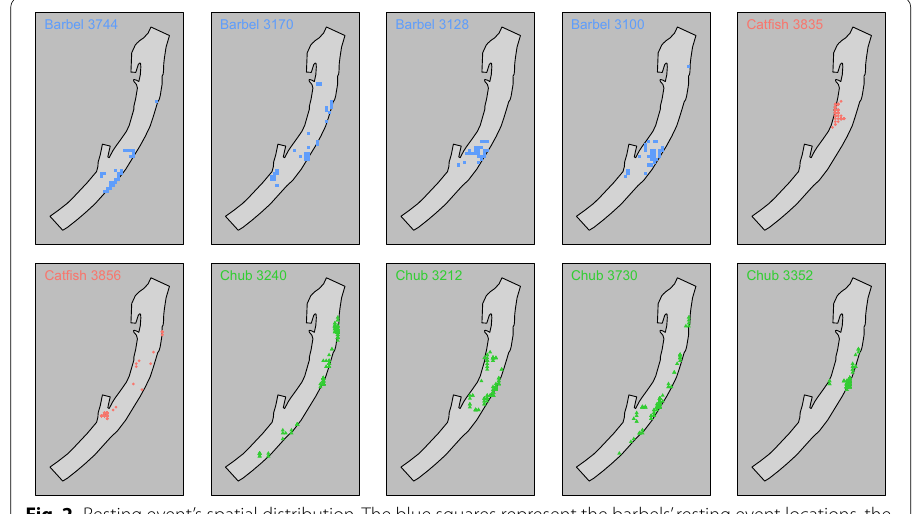
Fig. 2 Resting event’s spatial distribution. The blue squares represent the barbels’ resting event locations, the red squares stand for the catfish and the green circles for the chubs